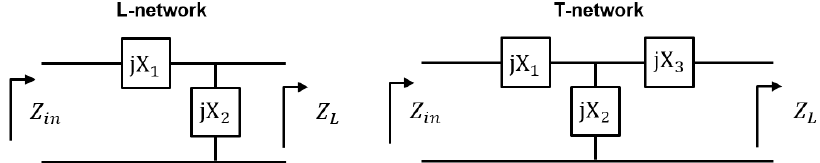
Figure 3. L and T circuit network topologies used for impedance matching in circuit